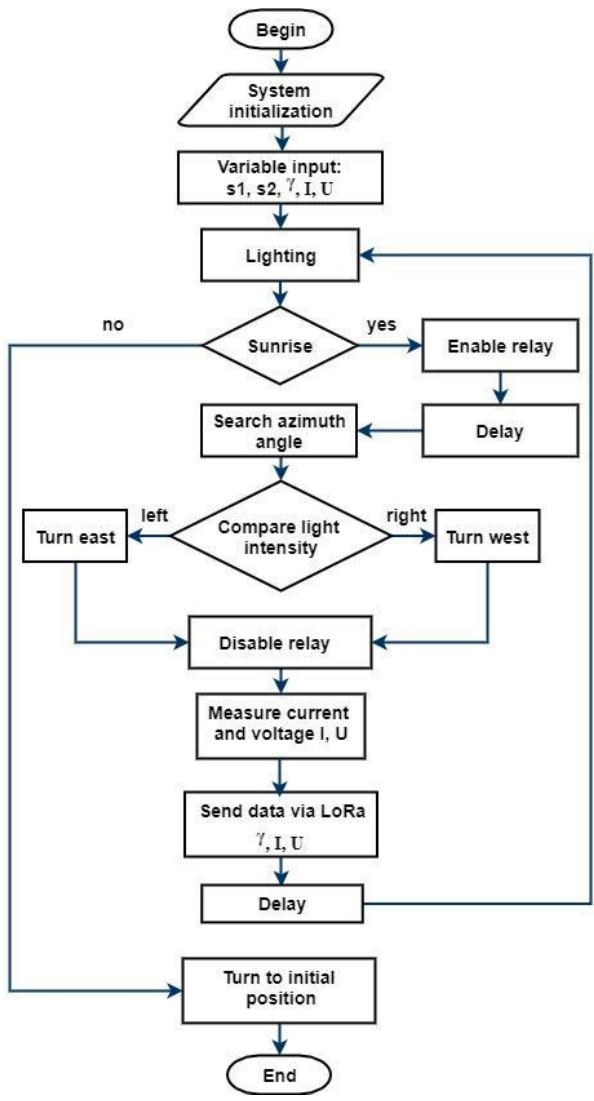
Figure 8. Algorithm for a single-axis solar tracker based on photosensors.